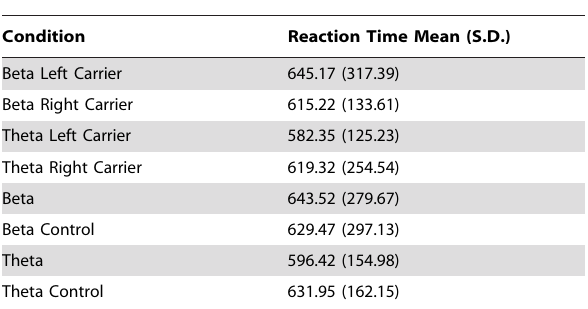
Table 2. Means and Standard Deviations of Reaction Time (ms) in the Vigilance Task during Beta binaural beat stimulation, Theta stimulation and Control conditions.